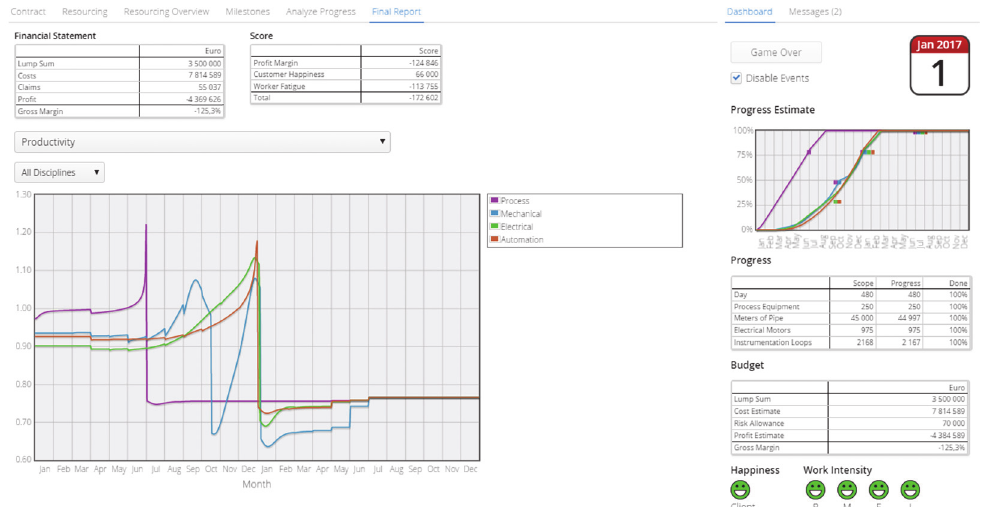
Figure 14: The final